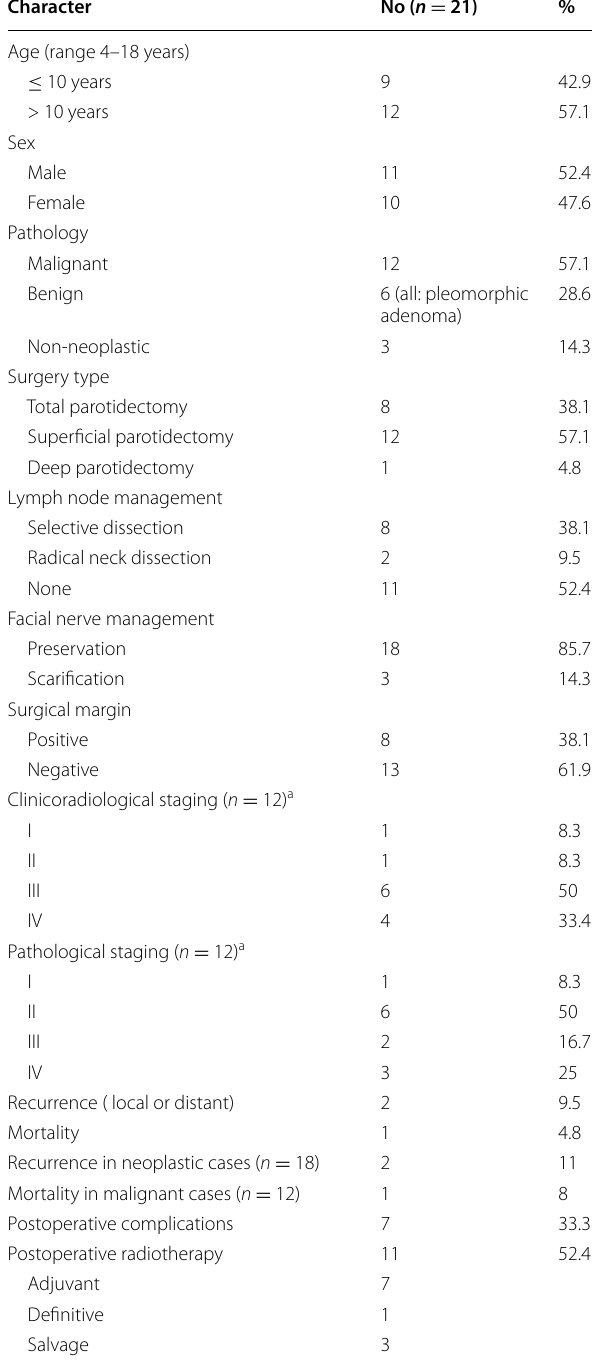
Table 1 Clinicopathological features of the